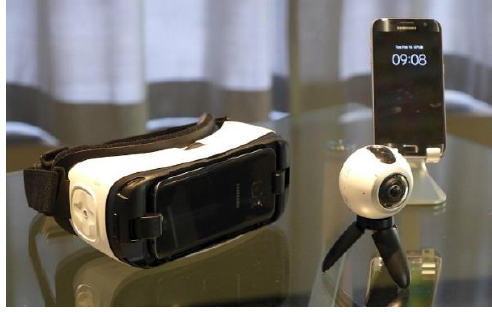
Figure 4. Equipment used for the research